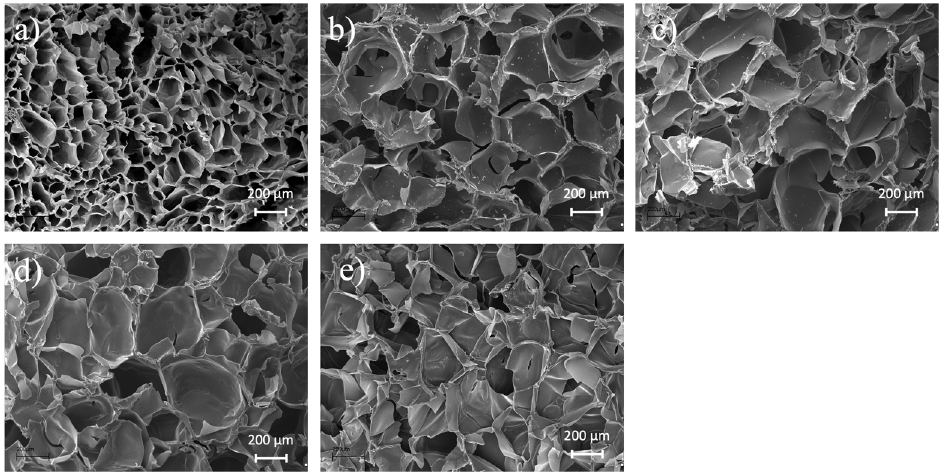
Figure 4. SEM images of the lyophilized samples: ( a ) unmodified gelatin, ( b ) gelatin–siloxane